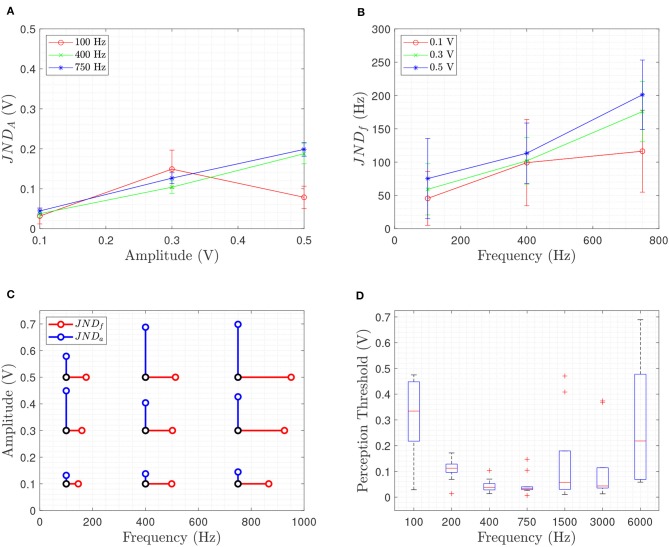
Results of the psychophysical evaluation of five subjects show the mean and standard deviation of the (A) JNDa giving the amplitude resolution for three different frequencies at three different amplitudes and (B) JNDf giving the frequency resolution for three different amplitudes at three different frequencies while (C) shows a summary plot of the obtained mean value of JNDa (blue) and JNDf (red) at each reference stimulus (black). In (D), the identified perception threshold value a0 at the frequencies [100, 200, 400, 750, 1500, 3000, 6000] Hz for 10 subjects, is shown.